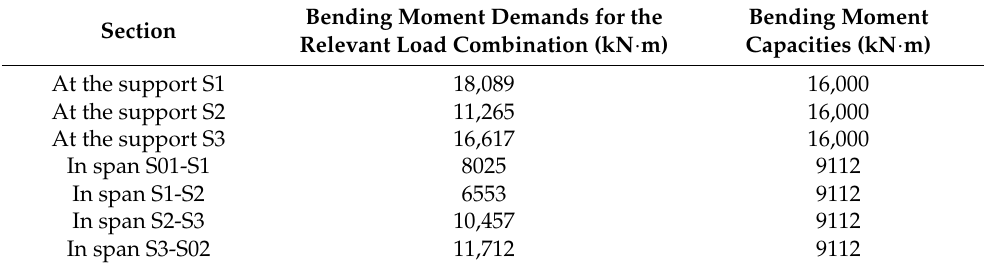
Table 1. Comparison of bending moment demands with the bending moment capacities of the main longitudinal